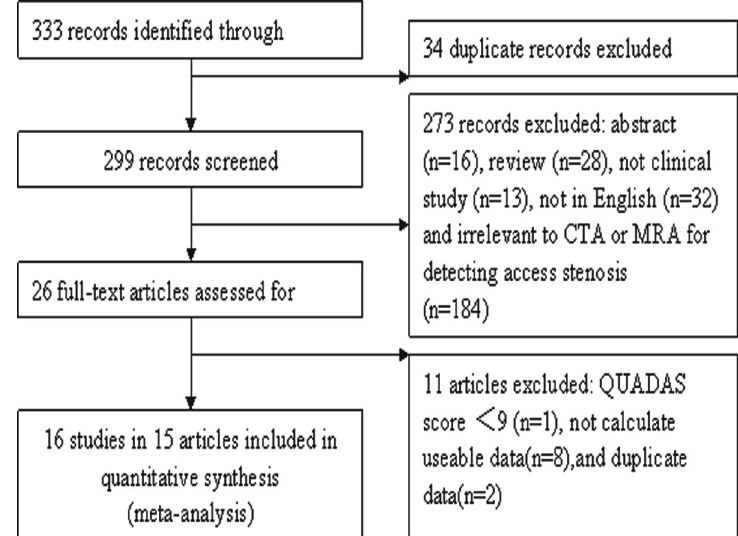
Figure 1. Flowchart of study identification, inclusion, and exclusion.